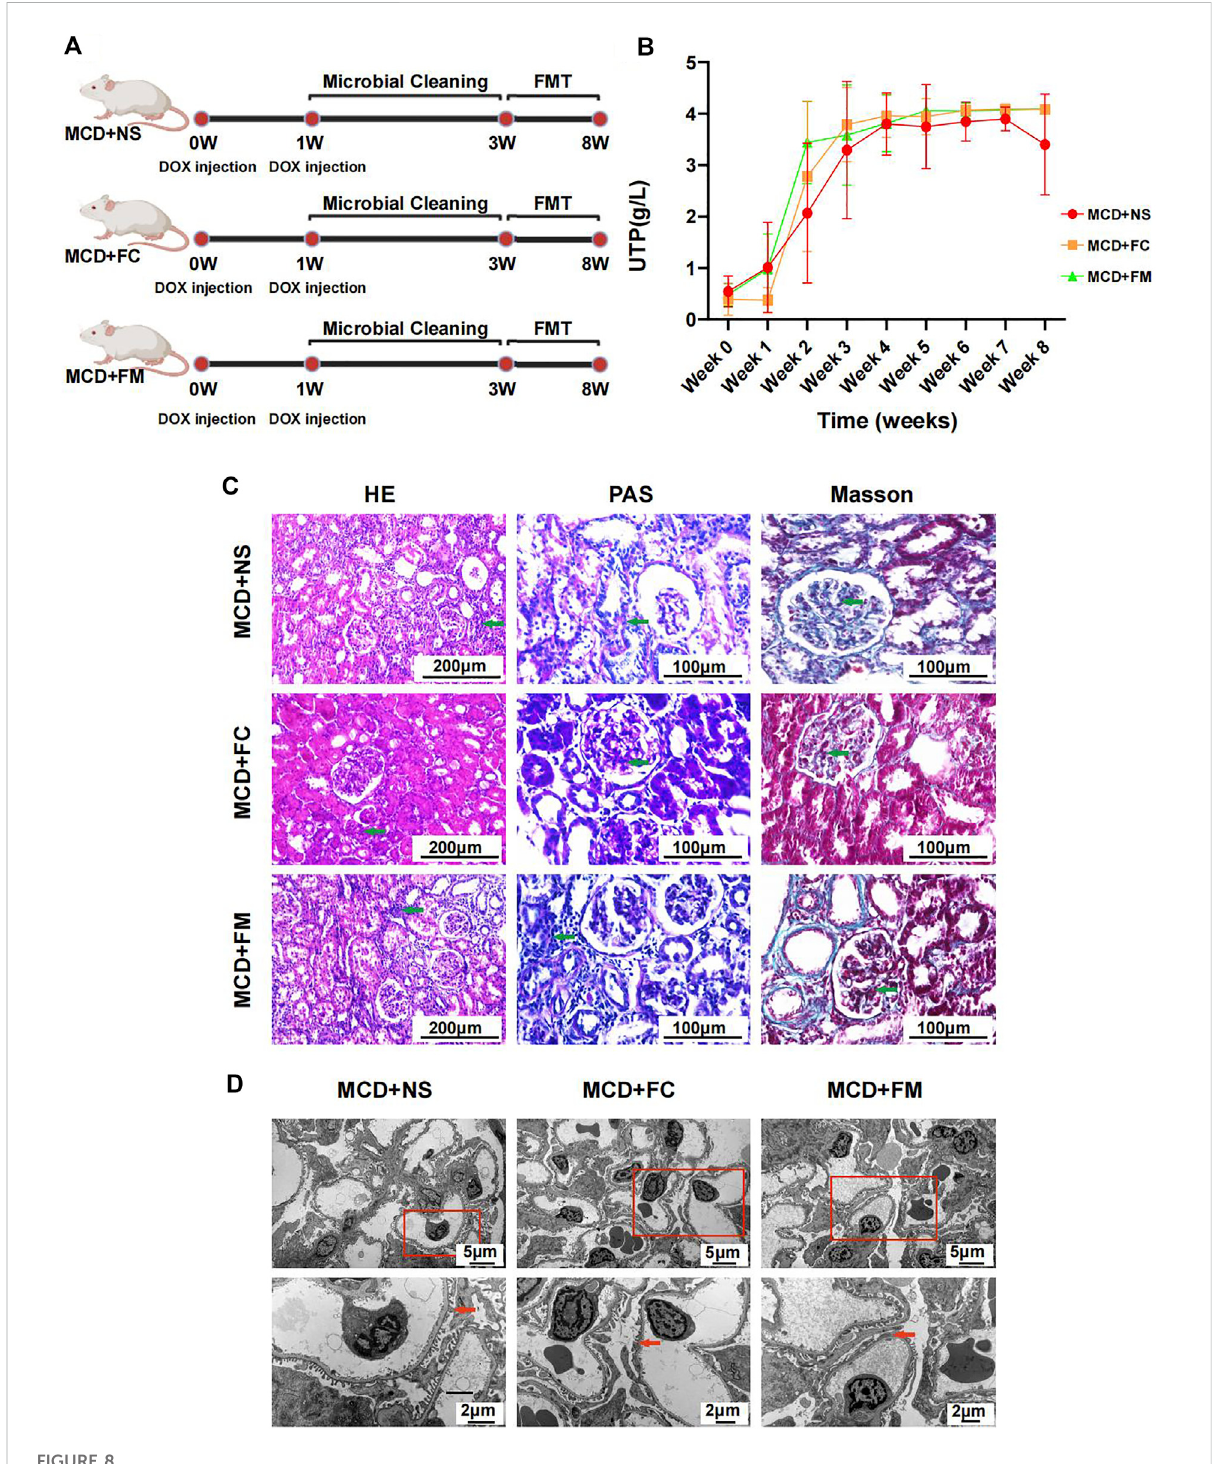
FIGURE 8 Modeling process and Pathological injury in MCD + NS group ( n = 7), MCD + FC group ( n = 7) and MCD + FM group ( n = 7). (A) After modeling, rats in three groups were given a two-week gut microbiota cleaning. Then FMT continued from week three to week eight in three groups. (B) Line chart showed the alteration of urinary protein after modeling. (C) HE, PAS and Masson staining of glomerulus in different groups. (D) Electron microscopy showed detailed pathologicalinjury ineachgroup. FMT,fecalmicrobiotatransplantation;FC,fecalmicrobiota transplantationwith feces from Con group; FM, fecal microbiota transplantation with feces from MCD